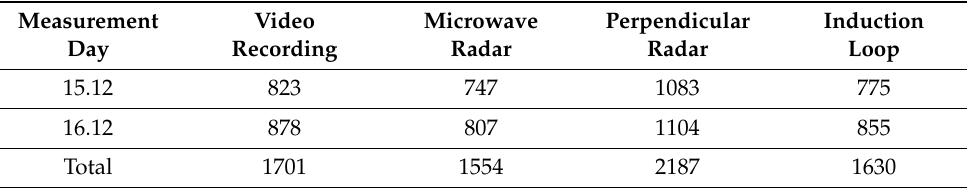
Table 5. List of all vehicles recorded at the Stefana Banacha street point, broken down by applied measurement method (own